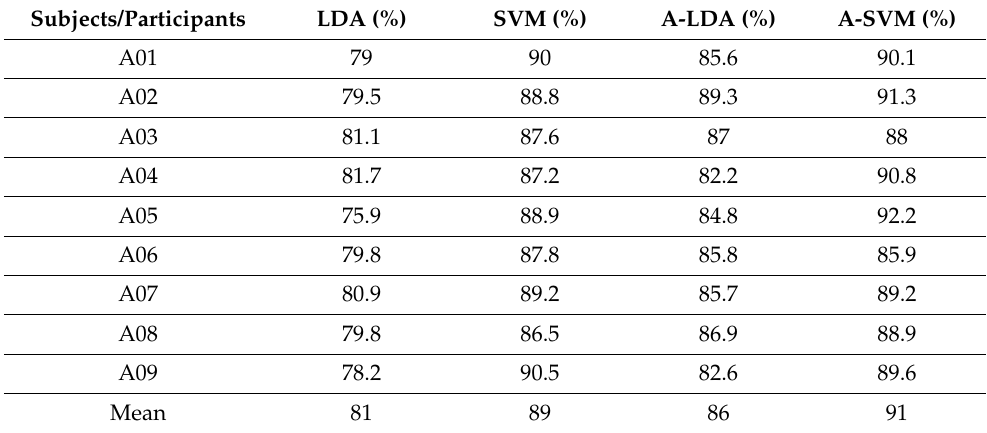
Table 3. Results of LDA, SVM, A-LDA, and A-SVM in terms of accuracy on Motor Imagery data.